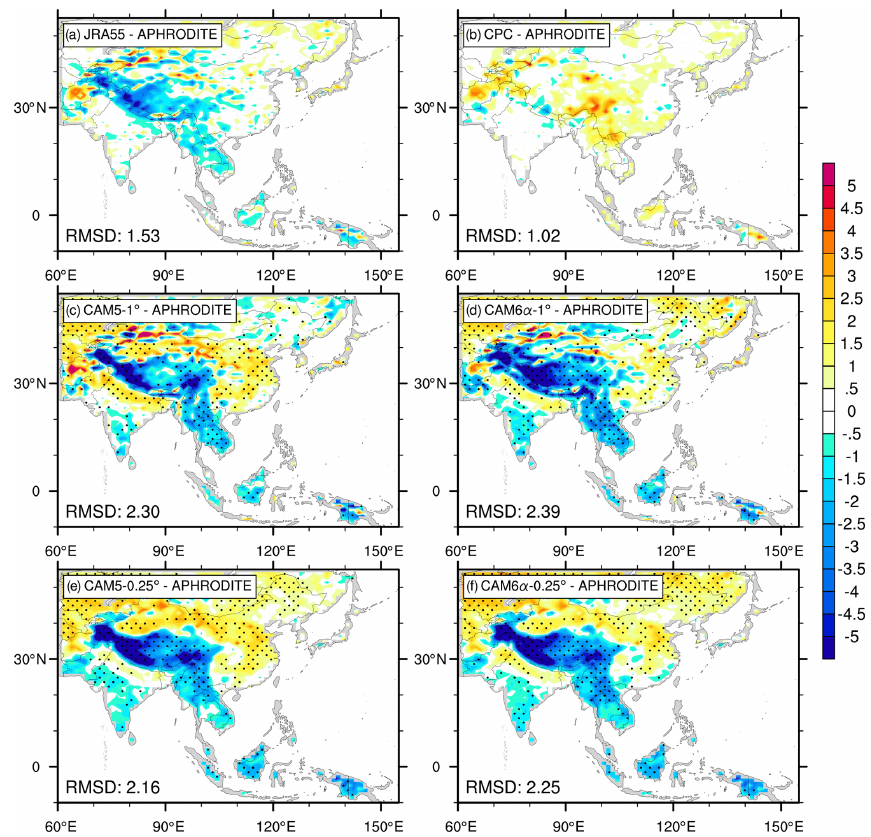
Figure 1. The difference of 1980–2004 annual mean surface air temperature ( ◦ ) between observations (APHRODITE) and (a) JRA55, (b) CPC, (c) CAM5-1 ◦ , (d) CAM6 α -1 ◦ , (e) CAM5-0.25 ◦ and (f) CAM6 α -0.25 ◦ . The values at the lower left of each panel indicate the root mean square difference (RMSD) relative to APHRODITE. Grid points in panels (c–f) are stippled if the absolute difference between the respective model and APHRODITE is larger than that between JRA55 and APHRODITE. All the data were interpolated to 1 ◦